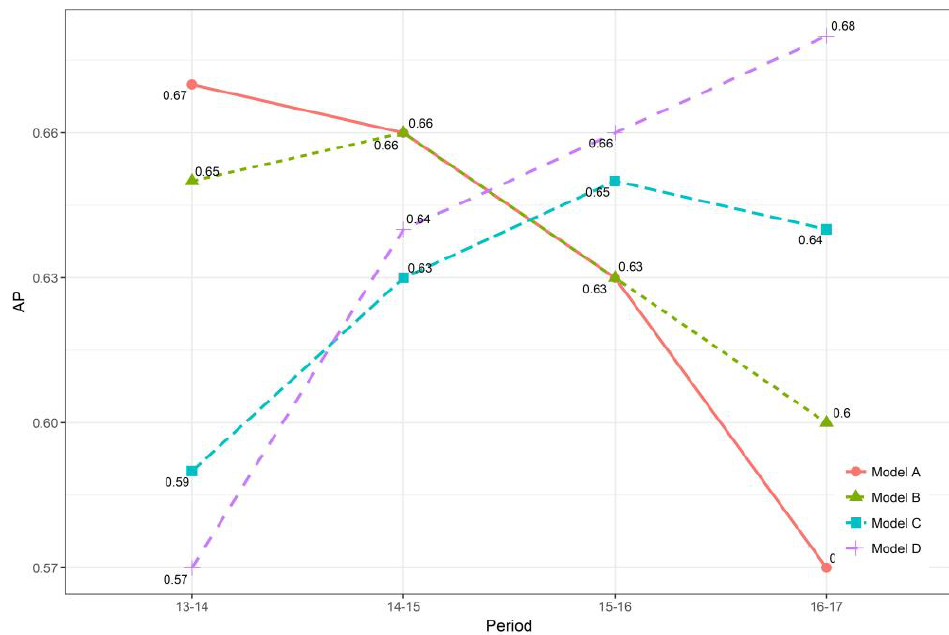
Figure 10. Temporal transferability results.